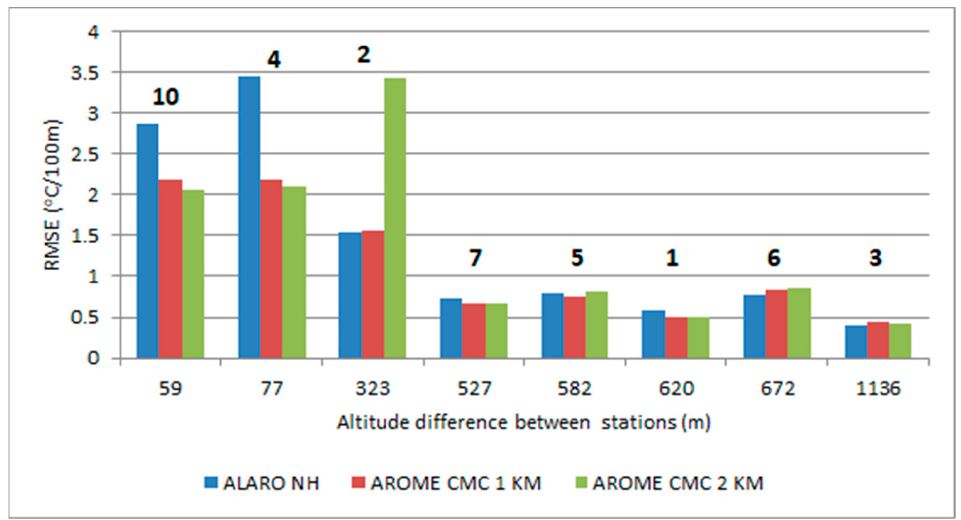
Figure 15. RMSE values for predicted temperature gradients for two kilometric scale resolution models (AROME CMC 1 km and ALARO NH) and operational AROME CMC 2 km as reference.